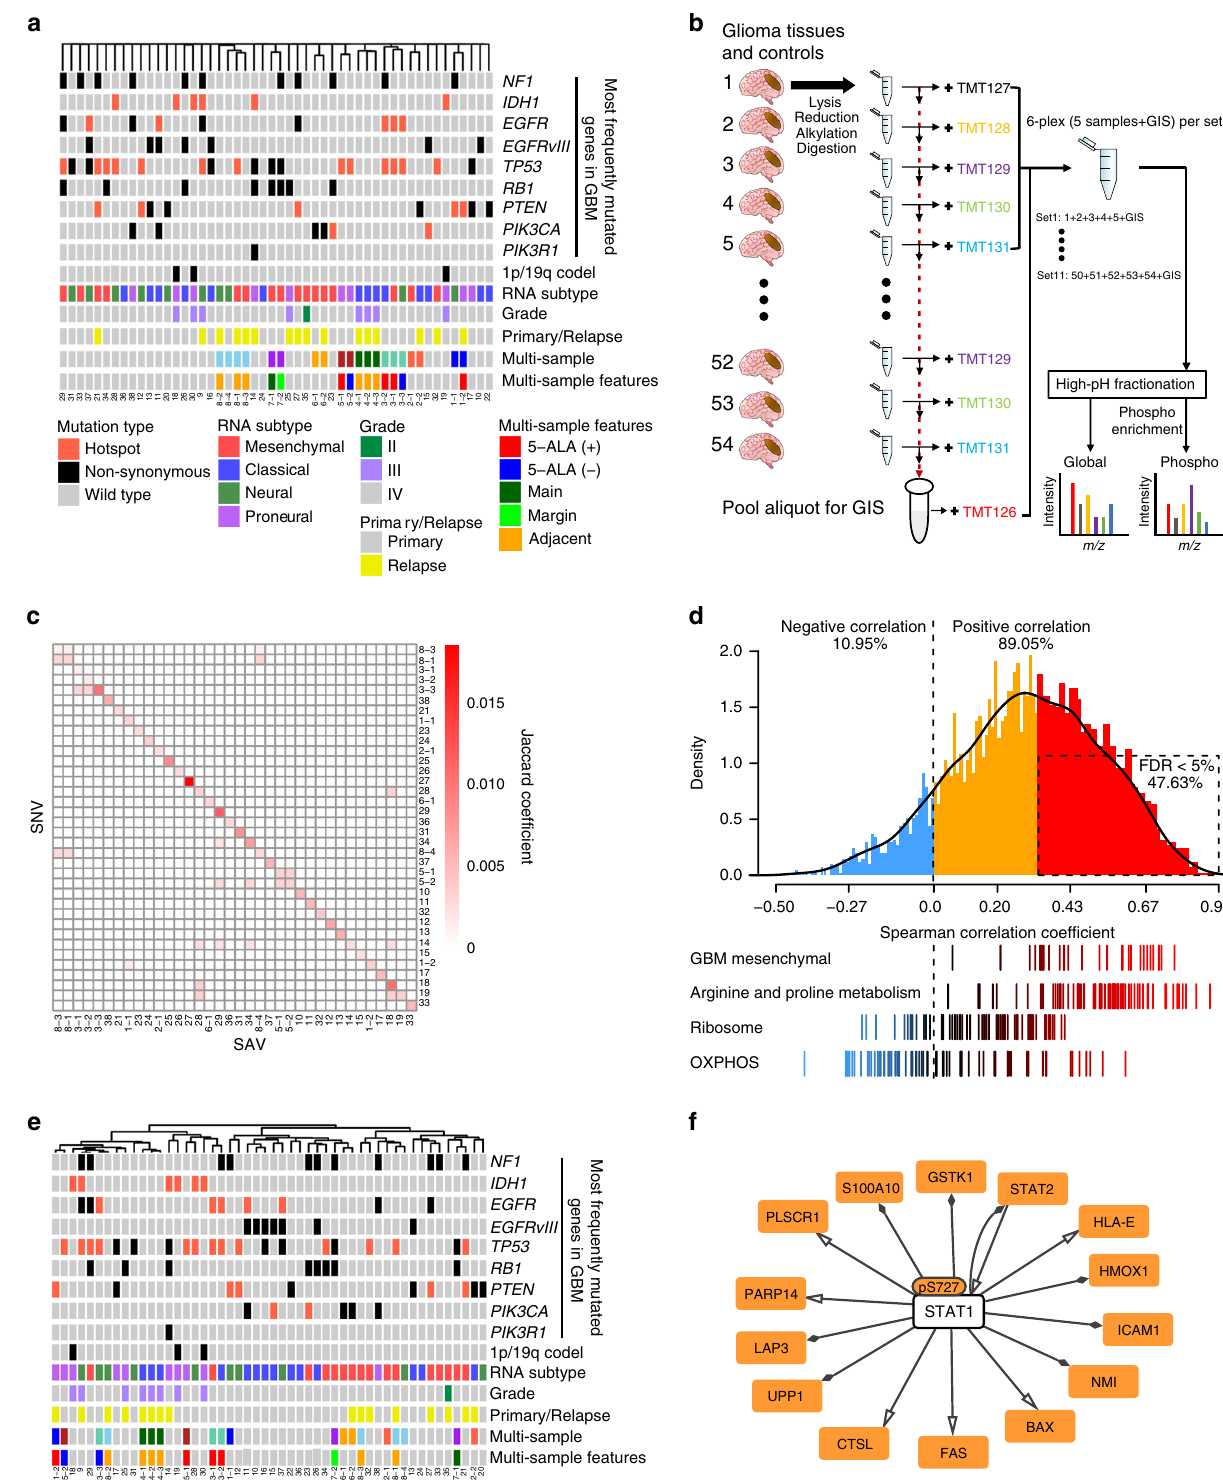
background (Supplementary Fig. 1f). Collectively, our results suggest that quantitative proteomic data can accurately cluster glioma samples by clinical phenotype and identify activated pathways and their regulators.